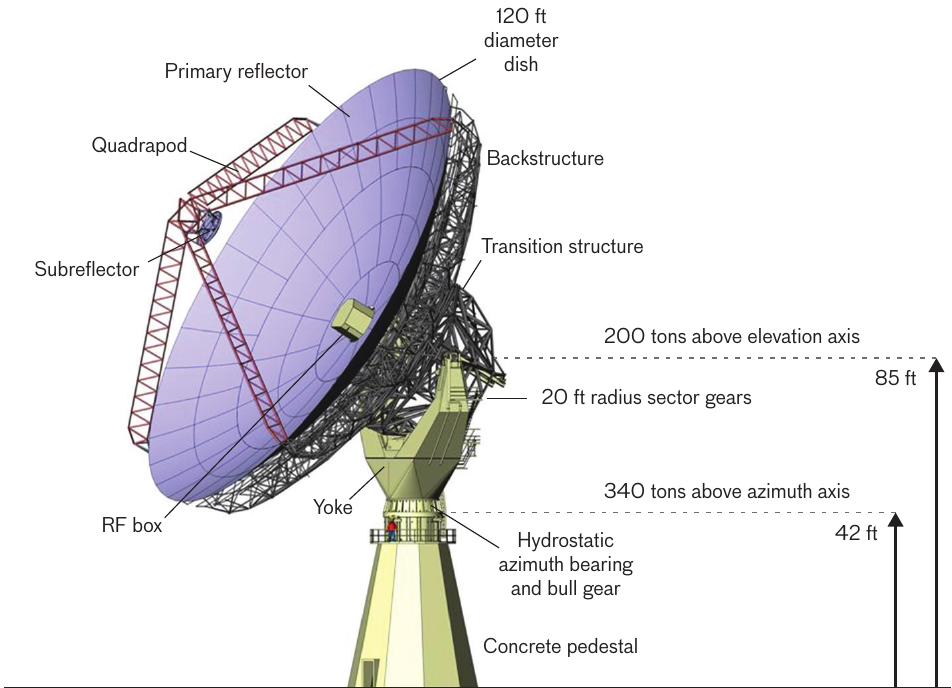
FIGURE 3. A computer-aided design rendering of the HUSIR antenna shows its key features. Figure 2. Overview of the Haystack Telescope, with the radome removed [8]. The receiver equipment is installed in the “RF box”, a container that is brought down to ground level during “box-down” periods to enable major engineering activities. (Reprinted with permission, courtesy of MIT Lincoln Laboratory, Lexington, MA,